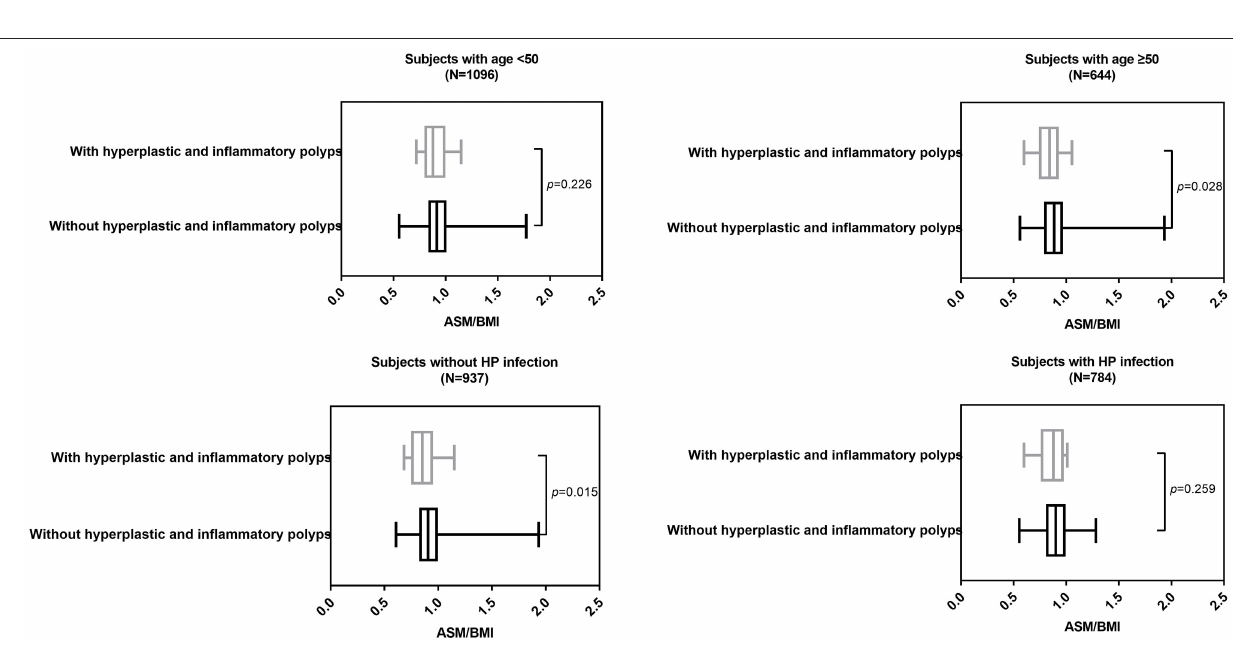
Frontiers in Medicine |